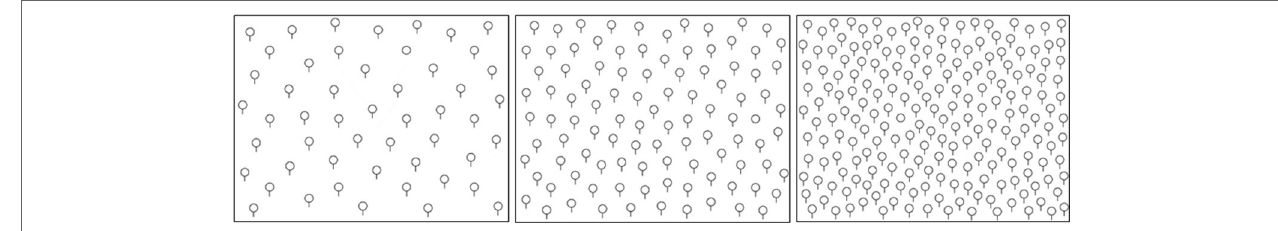
FIGURE 2 | Balloon task with three visual load